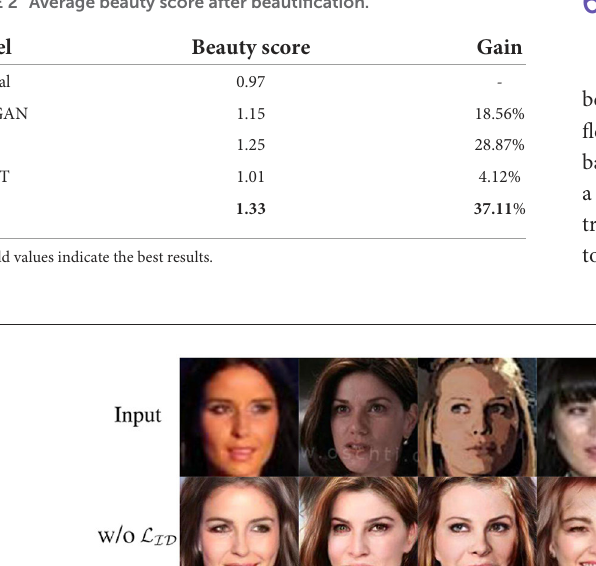
TABLE 2 Average beauty score after beautification.